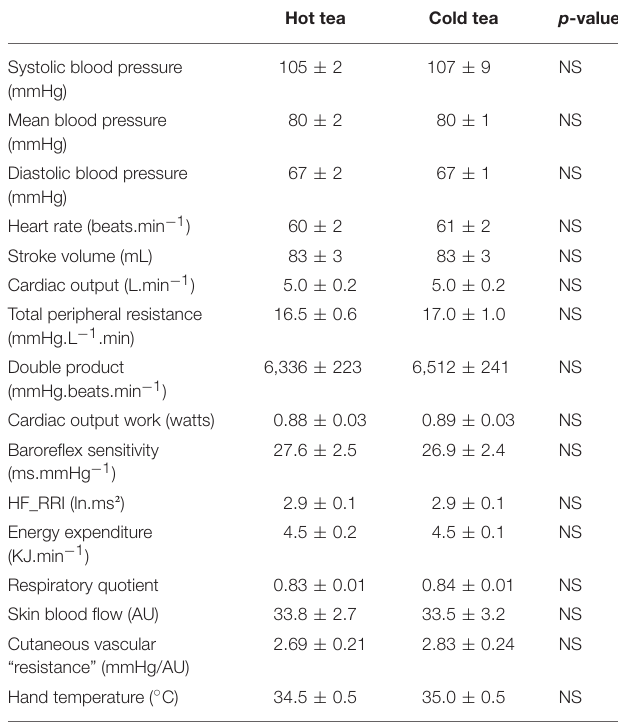
TABLE 1 | Baseline hemodynamic and metabolic data recorded prior to drink